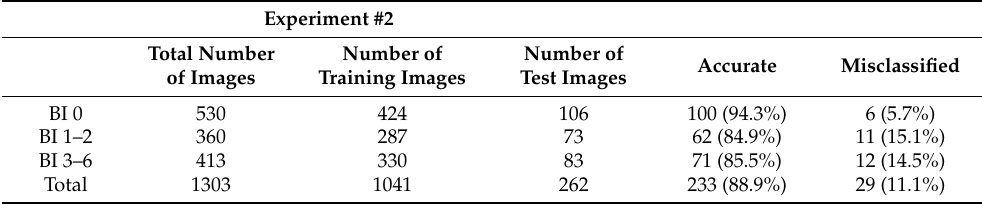
Table 2. Results of experiment Table 2 . Results of experiment #2 .